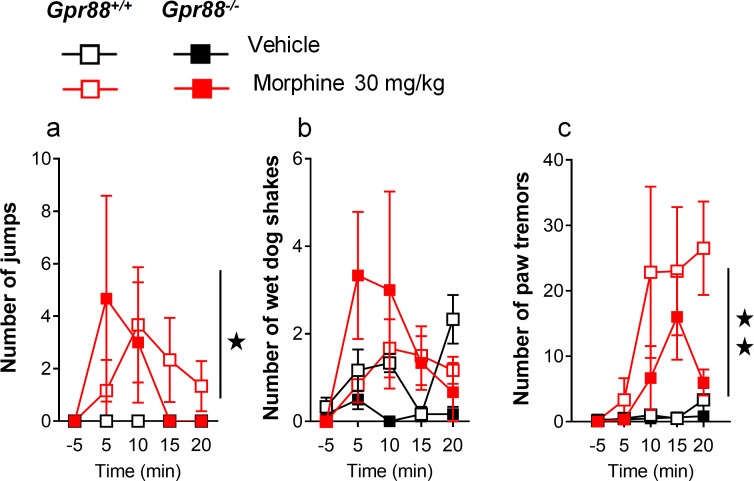
Additional morphine-induced withdrawal signs in Gpr88-/- versus Gpr88+/+ mice.After an exposure to escalating doses of morphine, Gpr88+/+ and Gpr88-/- mice (n = 6 per treatment and genotype) received an acute injection of naloxone (1 mg/kg) and withdrawal signs were quoted for 20 min. Gpr88 null animals and wild-type controls displayed similar numbers of jumps (panel a; Genotype: F1,20=0.02, p=0.9016; Treatment: F1,20=5.9, p=0.0246), wet dog shakes (panel b; Genotype: F1,20=2.4, p=0.1383; Treatment: F1,20=2.6, p=0.1222) and paw tremors (panel c; Genotype: F1,20=1.8, p=0.1913; Treatment: F1,20=9.0, p=0.0070; Time: F3,60=5.42, p=0.0023; Time x Treatment: F3,60=4.7, p=0054). Data are presented as mean ± SEM. Solid stars: treatment effect (two-way ANOVA with one repeated measure – day/5 min time bin), one symbol: p<0.05, two symbols: p<0.01; three symbols: p<0.001.